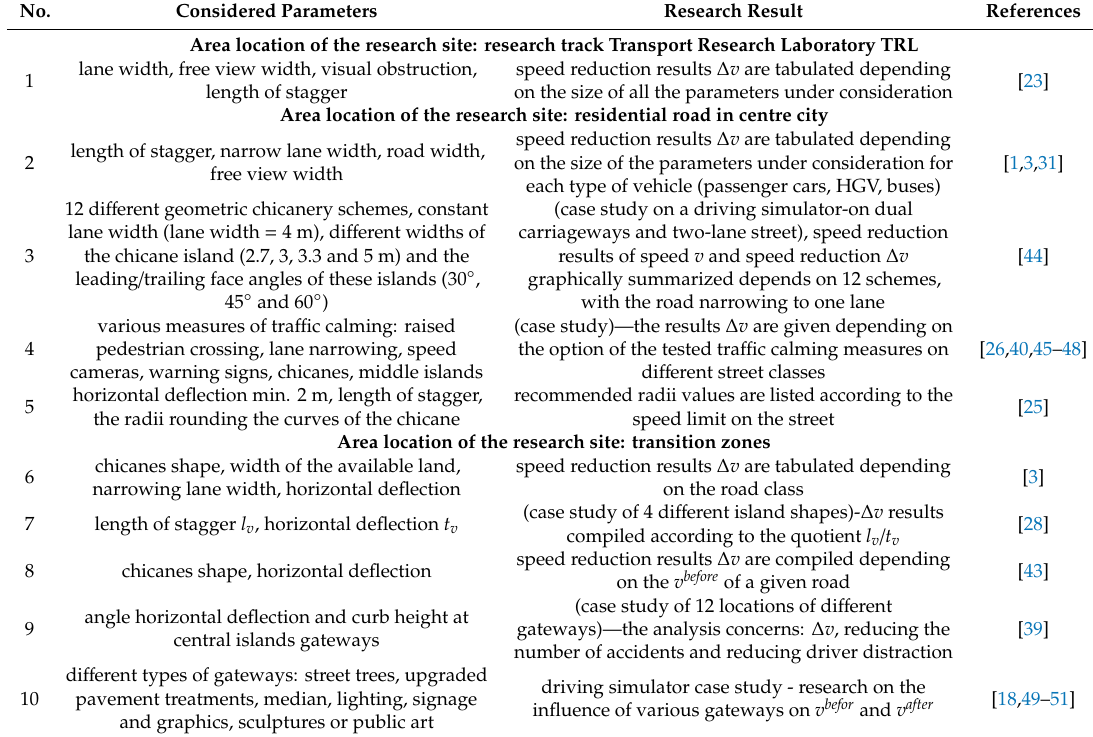
Table 1. Considered parameters, area locations and results of previous one’s